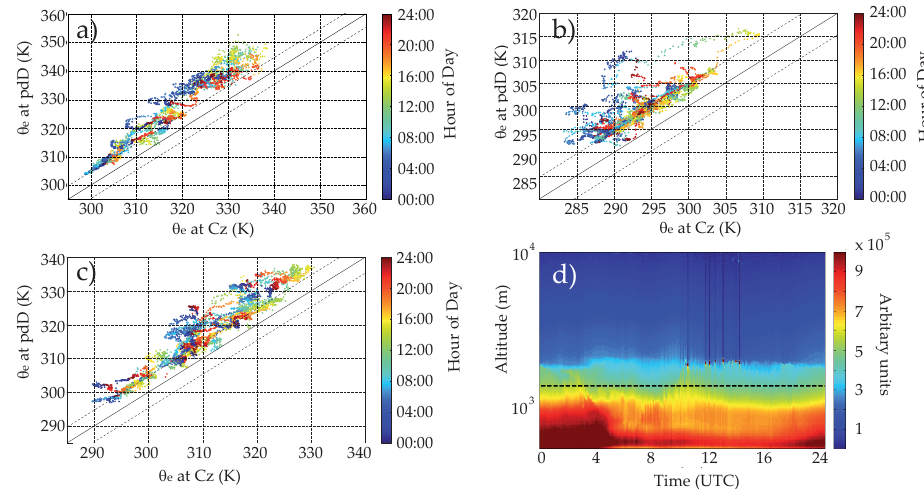
Fig. 1. Equivalent potential temperature ( θe ) determined from meteorological parameters measured at pdD and at the OPGC for the (a) autumn, (b) winter, and (c) summer campaign coloured by hour of day (UTC). (d) Lidar image, coloured by range-corrected signal at 355nm (arbitrary units) taken during the summer campaign showing that the pdD station was always in the boundary layer (values greater than 3 × 105). The dark dotted line represents to the height of the pdD (1465m